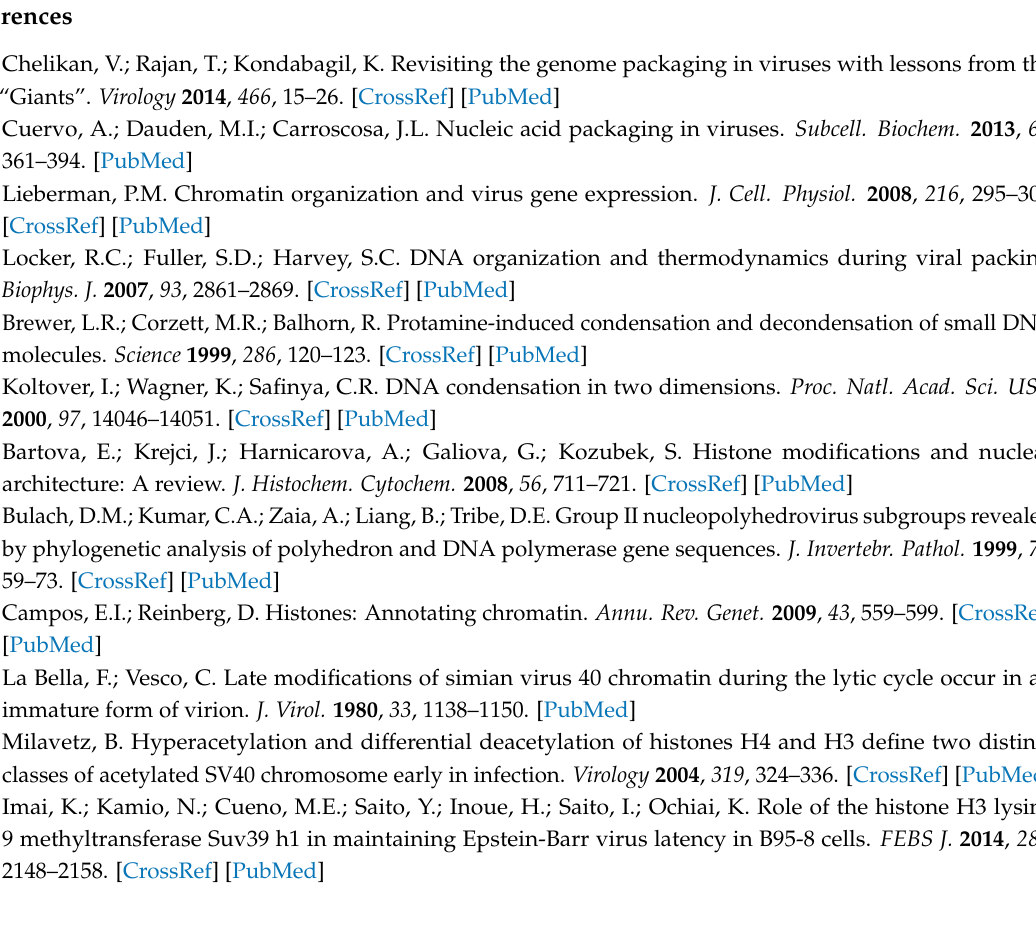
Figure S1a: Amino acid sequences of Chilo iridescent virus 6 (CIV 6, IIV6)-178R ORF orthologs in classified (a) and unclassified (b) invertebrate iridescent viruses (IIV); Figure S1b: Amino acid sequences of SfAV1a-048R ORF orthologs; Figure S1c: Proteins having the potential to function like SfAV1a P64 protein in some invertebrate iridoviruses (IIV) and members of Lymphocystivirus and